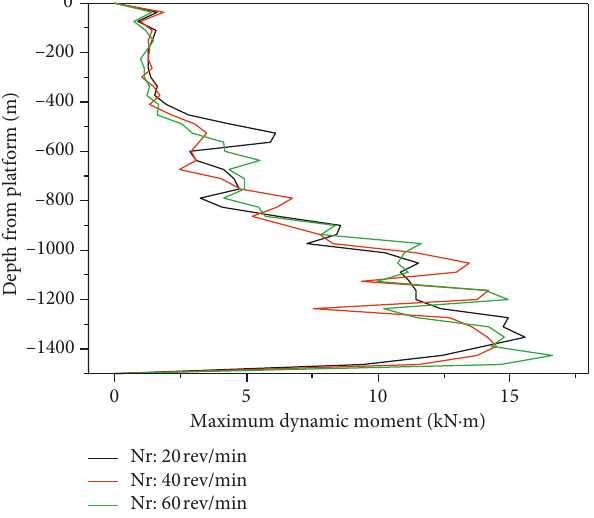
Figure 24: Effect of bit speed on maximum dynamic moment.